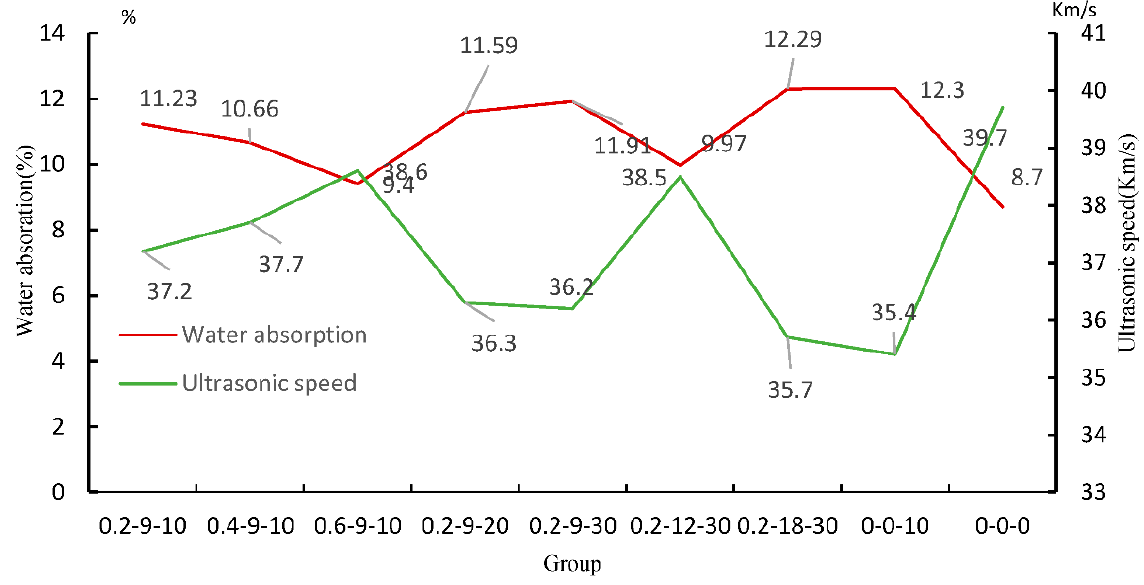
Figure 13. Contrast diagram of the ultrasonic wave velocity and water absorption.